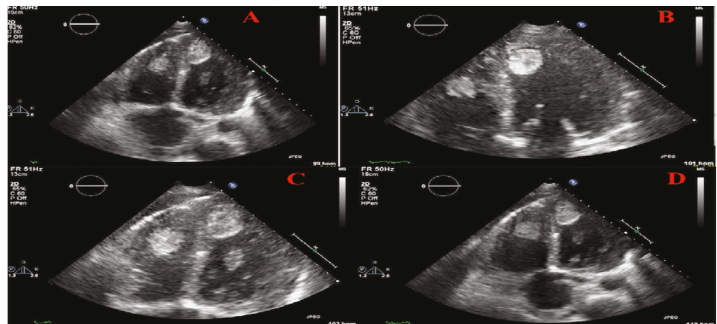
Figure 1: Transthoracic echocardiography, apical 4-chamber views, and multiple pedunculated 2-3 cm echodensities in the right and left ventricles consistent with intracardiac thrombi (a – d): moderate left ventricular hypertrophy (a), borderline LV dilatation (b), right ventricle appears moderately dilated (c), and intra-atrial septal deviated to the left (d). There is a small pericardial e ff usion.